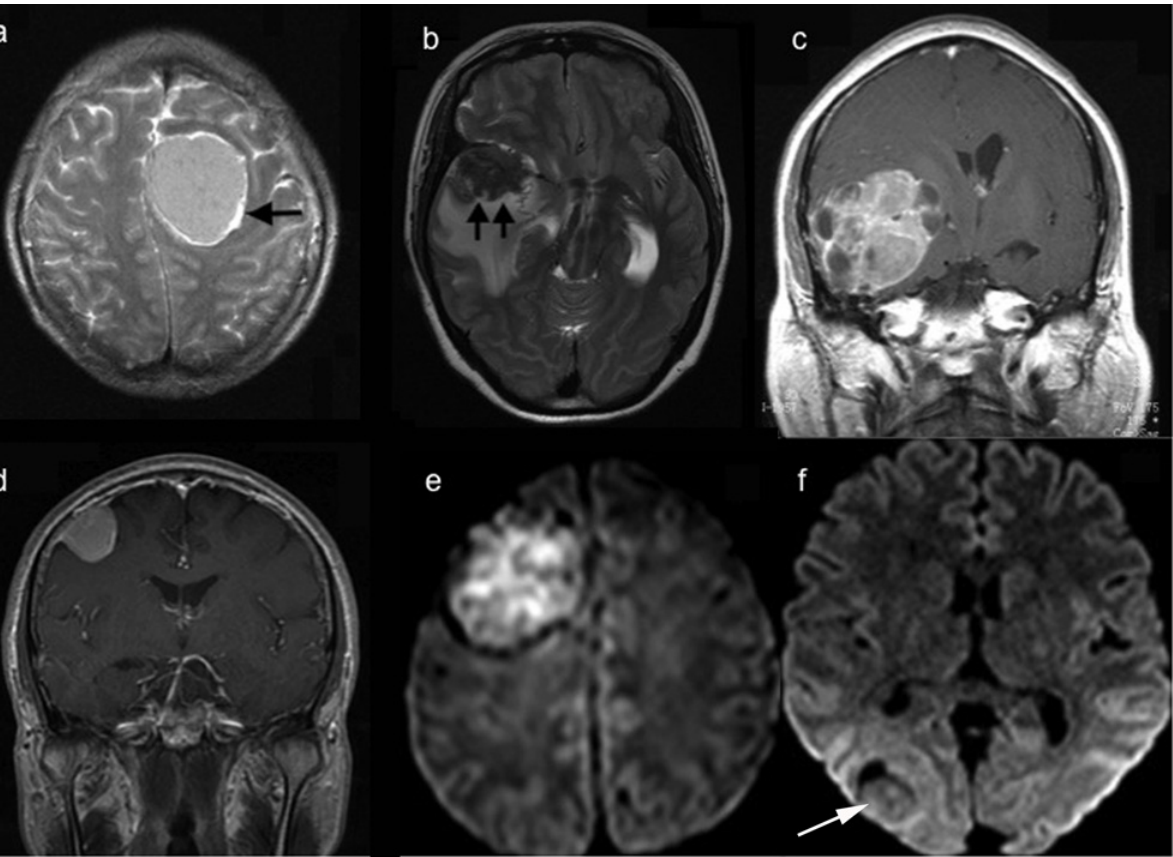
Fig 1. Radiologic characteristics of meningiomas in preoperative MRI. a) T2-weighted MRI demonstrating the complete arachnoid ring (black arrow) and no peritumoral edema; b) T2-weighted MRI demonstrating the disappearance of arachnoid ring (black arrow head) and peritumoral edema c) T1- weighted gadolinium enhanced MRI demonstrating heterogeneous enhancement and irregular shape of the tumor; d) T1-weighted gadolinium enhanced MRI demonstrating homogenous enhancement and regular shape of tumor; e) Diffusion weighted MRI demonstrating hyperintense lesion; f) Diffusion weighted MRI demonstrating isointense